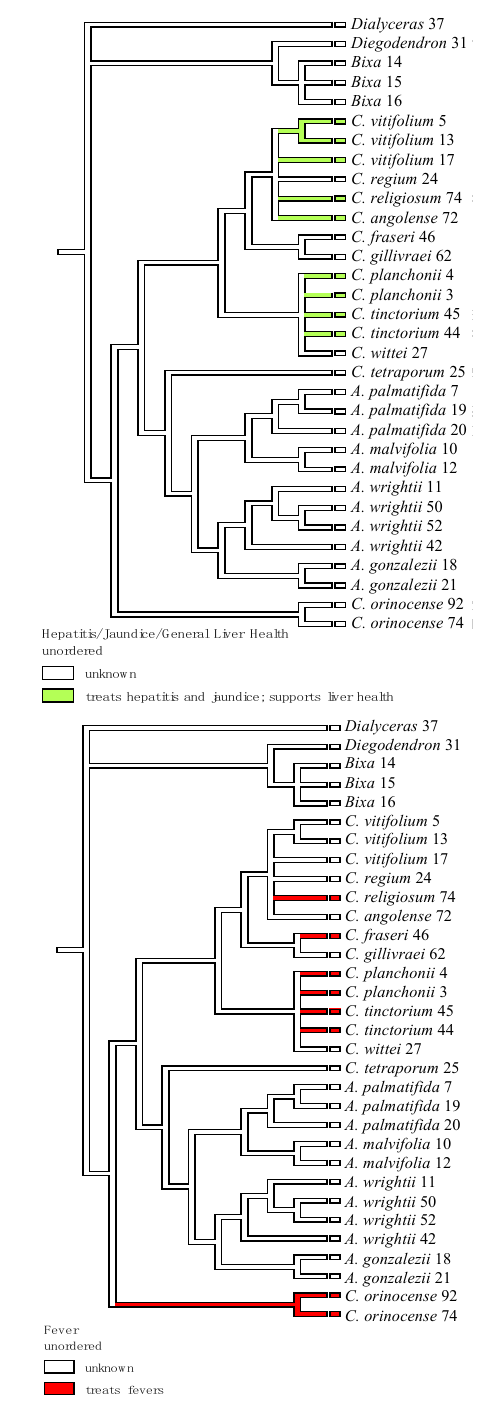
Figure 8. Medicinal uses (treatments for malaria, hepatitis/jaundice/other liver issues, yellow fever, and general fever) shared by two or more species mapped (as unordered character states) onto the Bayesian inference phylogeny of Cochlospermaceae of the combined nuclear (ITS) and plastid ( trnG and trnL-F ) regions from Johnson-Fulton and Watson